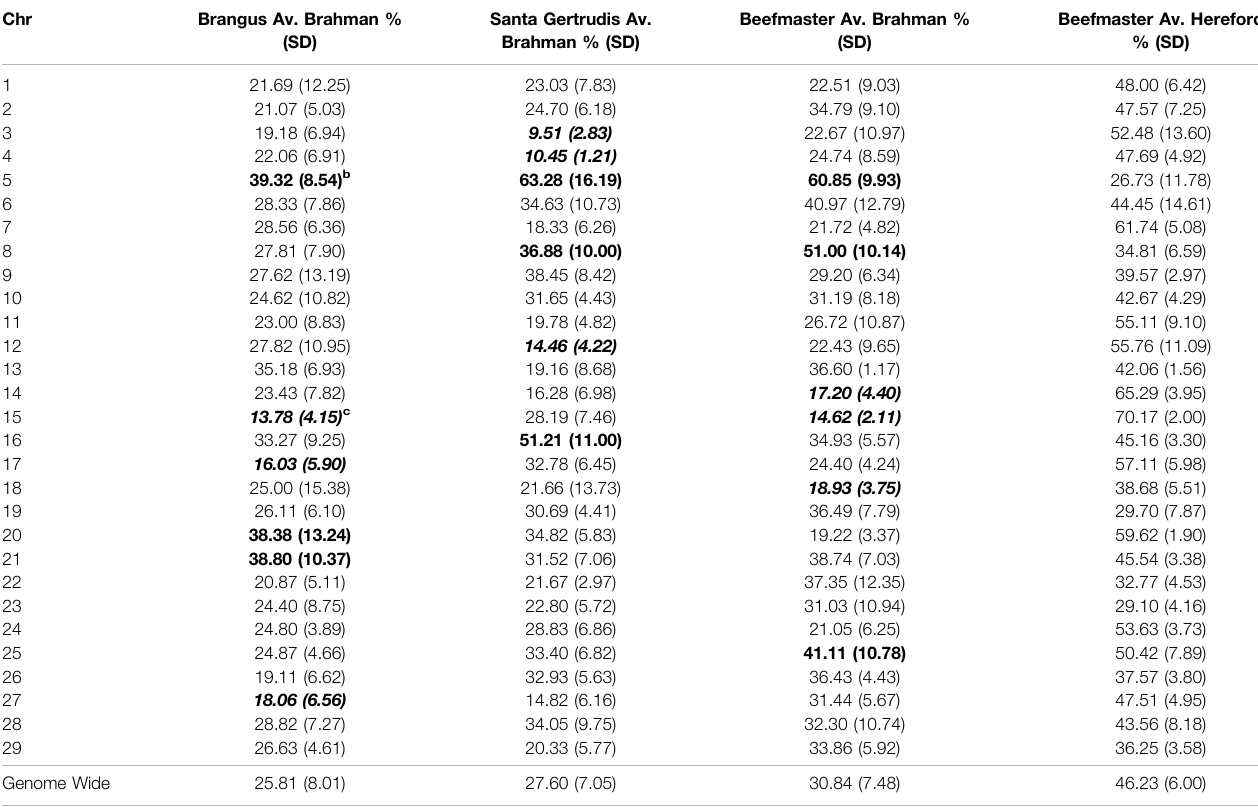
TABLE 3 | Average ancestry to reference populations by chromosome for each of the American breeds a .